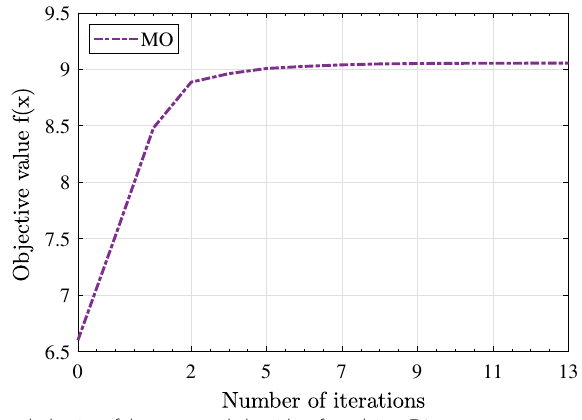
Fig. 6 Convergence behavior of the proposed algorithm for solving P